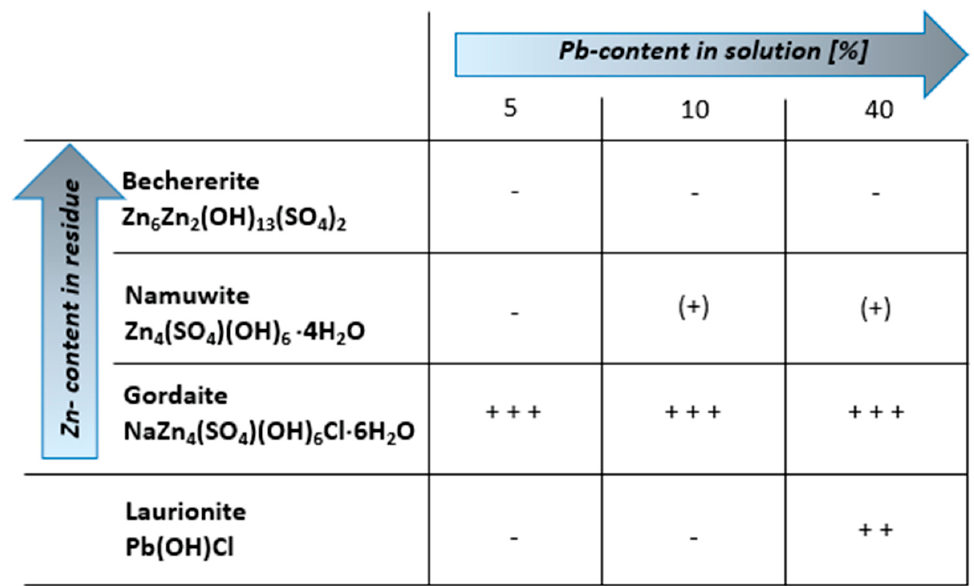
Figure 9. Crystalline phases in the Zn–Pb–salt system (exp. set 3) as a function of Pb concentration in the AQ (the number of + equals the relative amount of the phase in the residue, (+) indicates traces of the phase, - means phase not present).